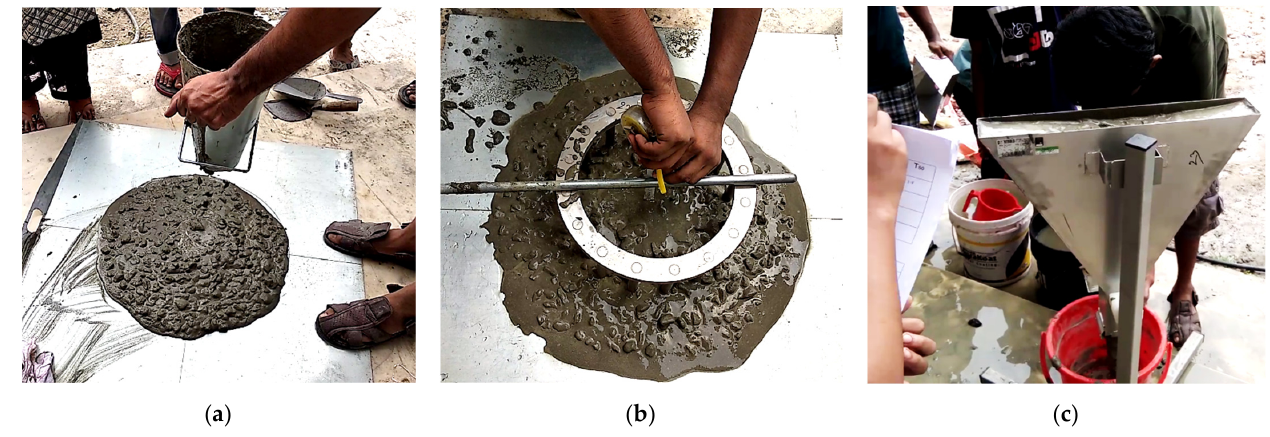
Figure 4. Experimental setup of fresh concrete test, ( a ) slump flow test, ( b ) J-ring test, ( c ) V-funnel test.